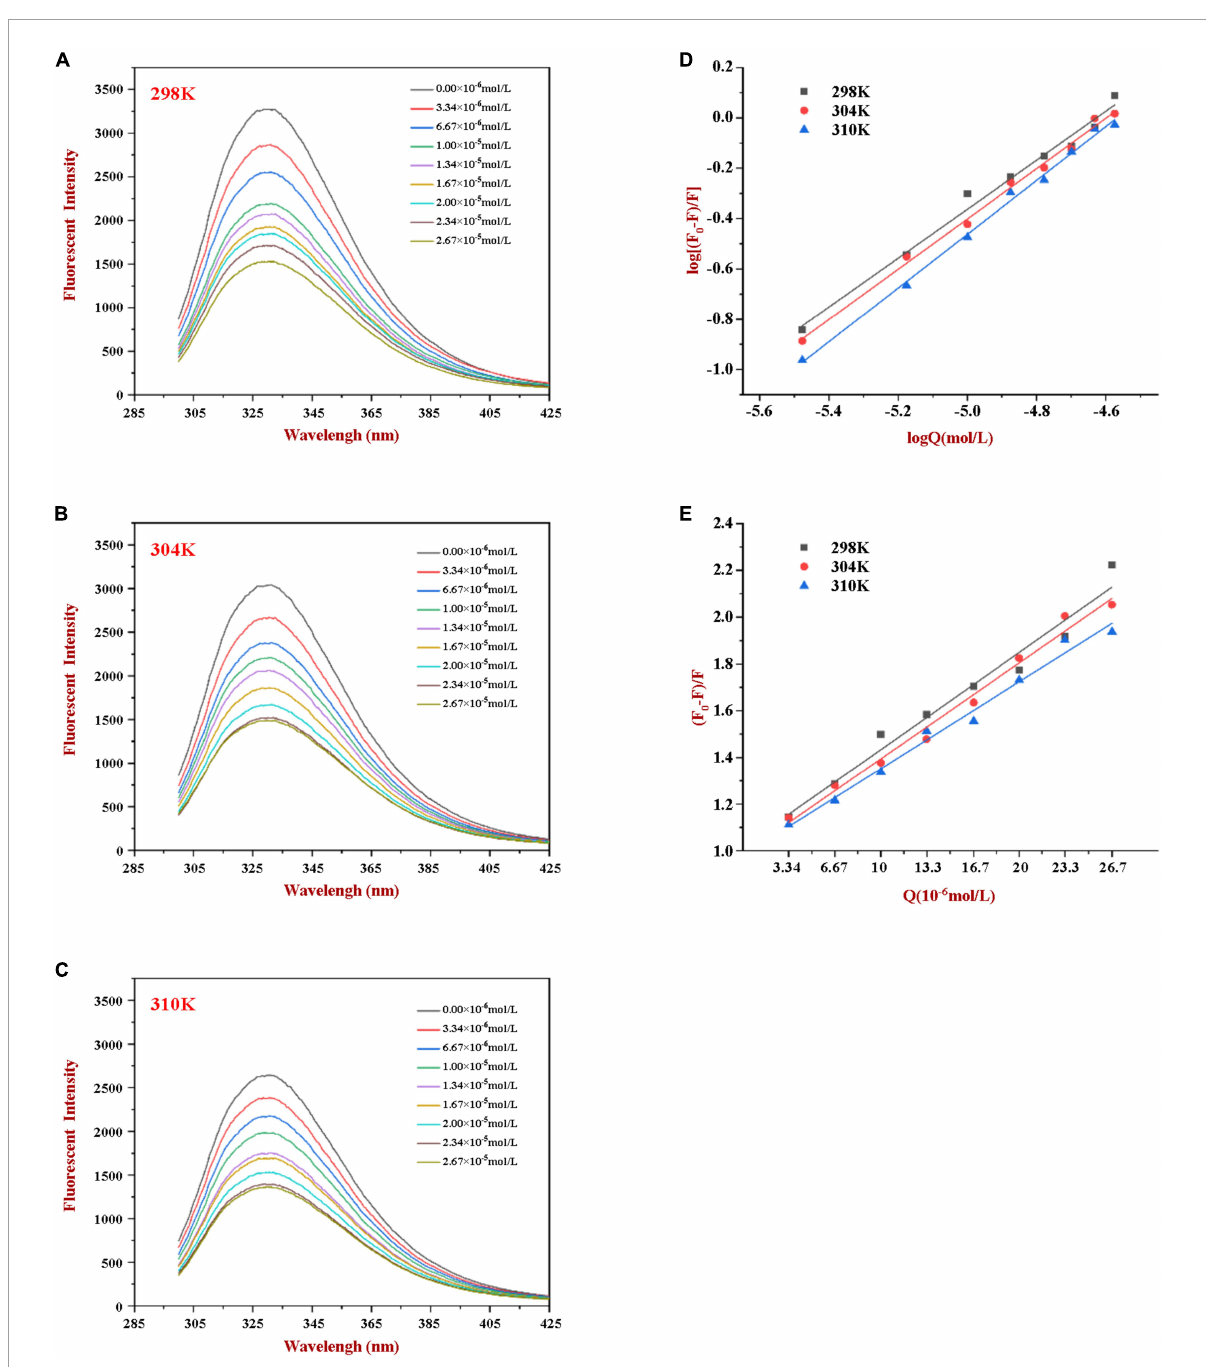
FIGURE1 Fluorescence emission profiles of WP at various concentrations of HES (0–26.7 µ M) at 298K (A) , 304K (B) , and 310K (C) . The Double-log plots (D) and Stern-Volmer plots (E) of the interaction between WP and HES at different temperatures.